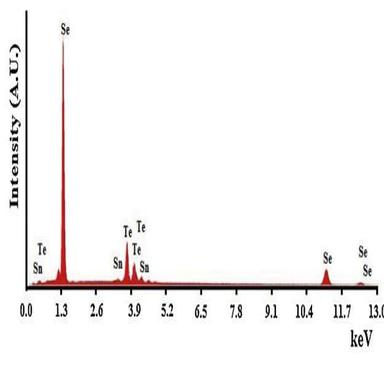
EDX patterns of (a) the unexposed sample (0 kGy) and (b) the exposed sample (12 kGy) of STS ChGA.